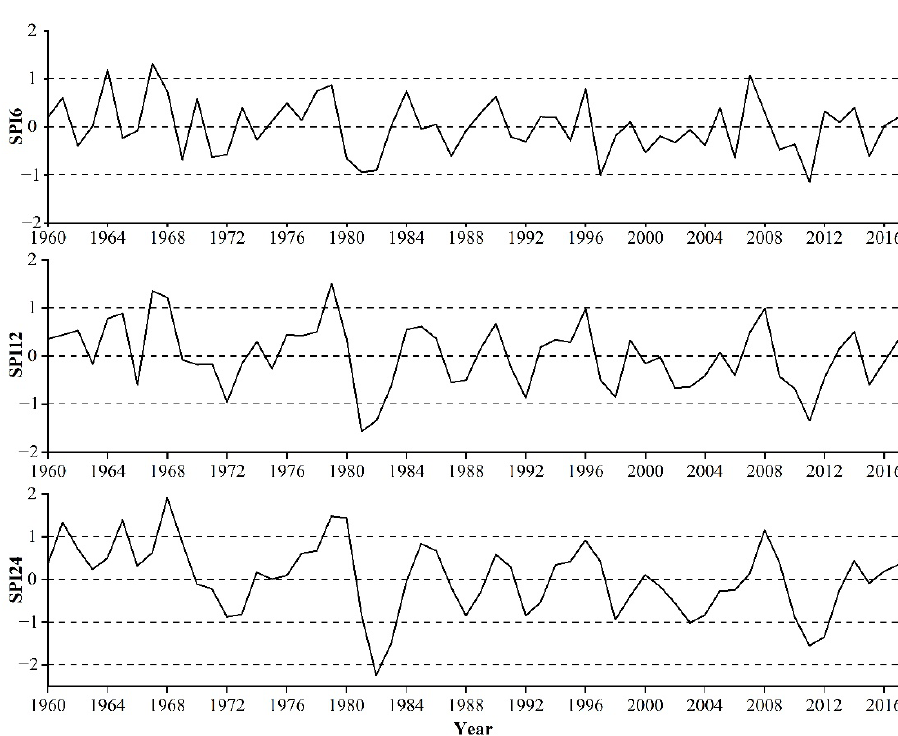
Figure 3. SPI time series variability at different time scales from 1960 to 2017.